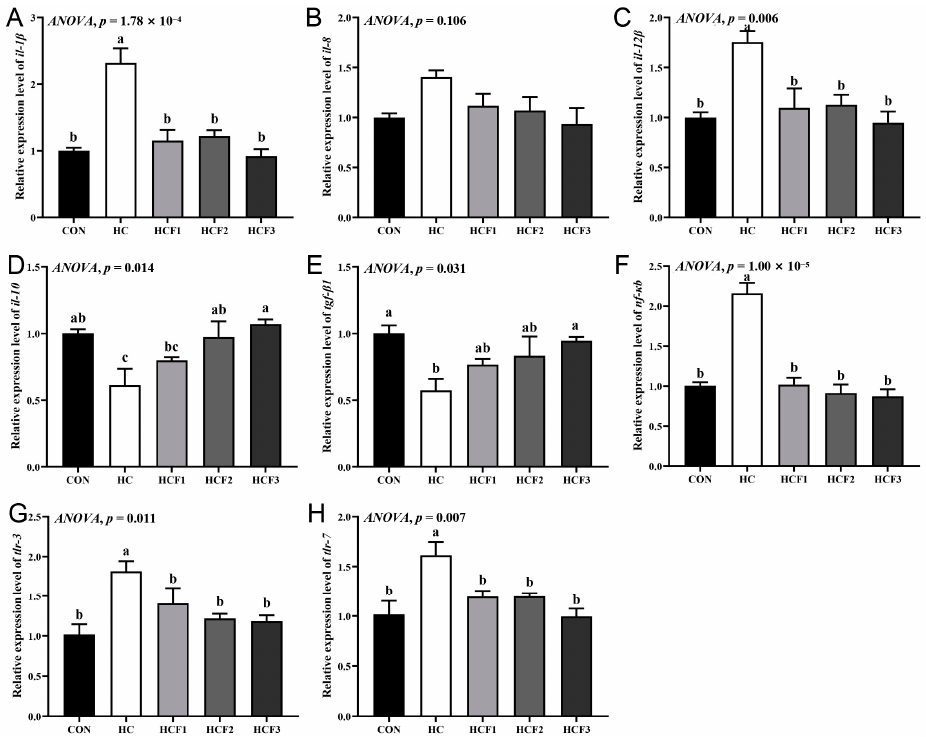
Figure 5. Influences of dietary mulberry leaf flavonoids on inflammation-related genes' expression in the liver of rice field eel fed on a high-carbohydrate diet. ( A ) il-1 β ; ( B ) il-8 ; ( C ) il-12 β ; ( D ) il-10 ;